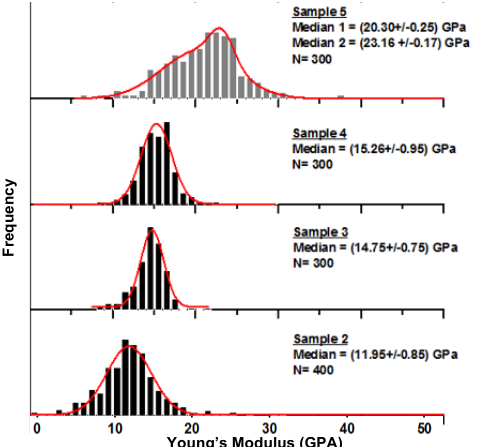
Figure 5. Mechanical data and distribution of Young’s modulus obtained for sample 2, 3, 4 and 5.